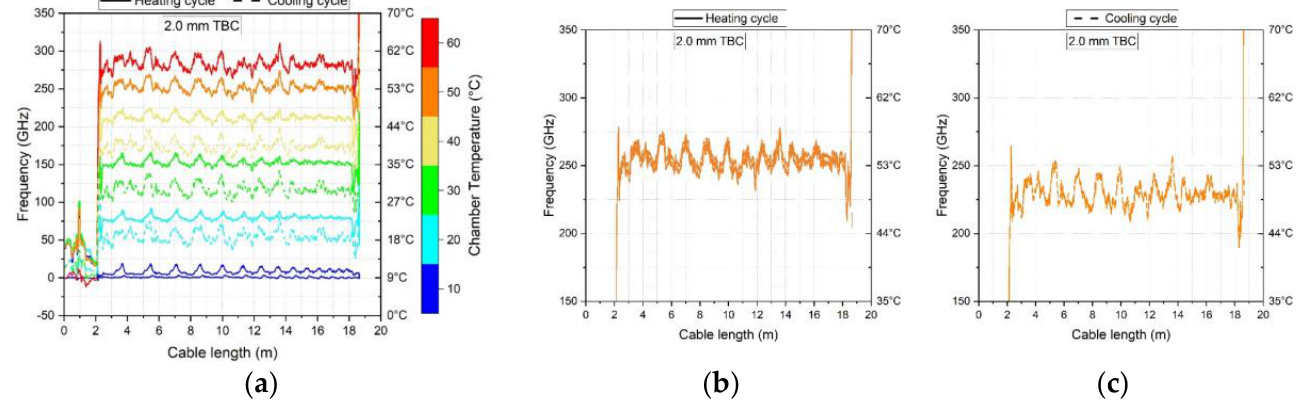
Figure 9. Length stability of the 2.0 TBC cable exposed to different temperature levels. ( a ) frequency shift versus cable position during heating and cooling ( b ) shifts associated with three time points at 50 °C during heating ( c ) shifts associated with three time points at 50 °C during cooling.